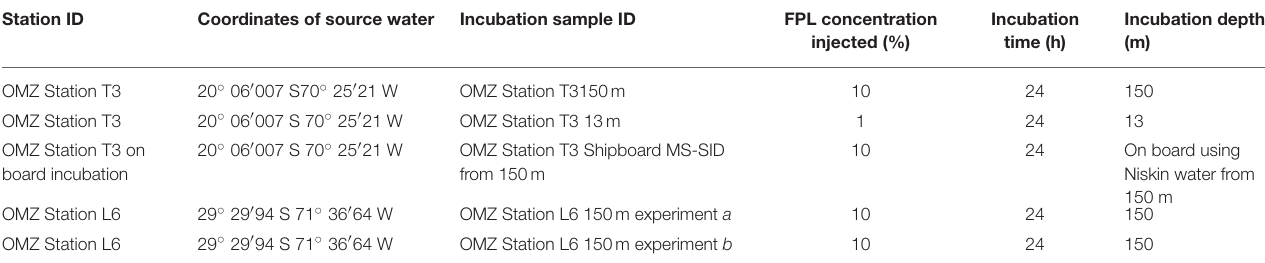
TABLE 1 | Station information, and incubation experiment features for grazing studies conducted using waters collected from the ETSP OMZ. Station ID